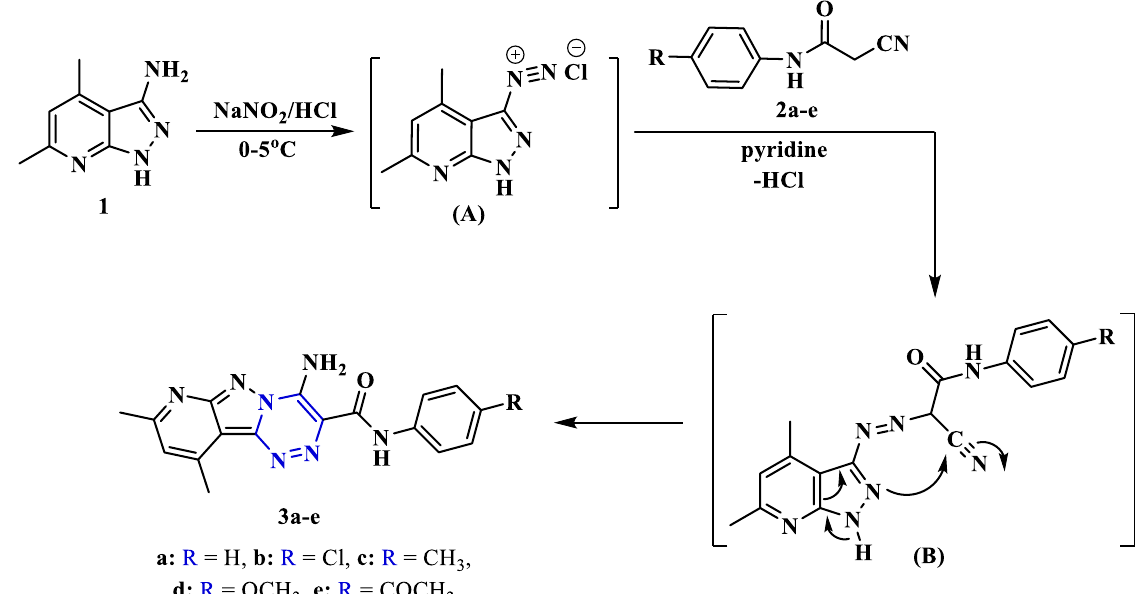
Figure 2. Synthesis of pyridopyrazolo-triazine derivatives 3a-e